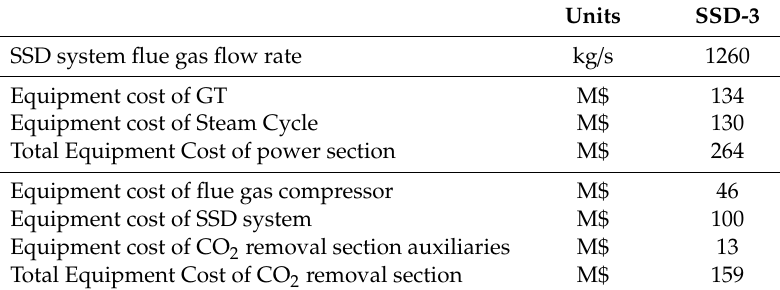
Table 21. SSD main results of equipment cost